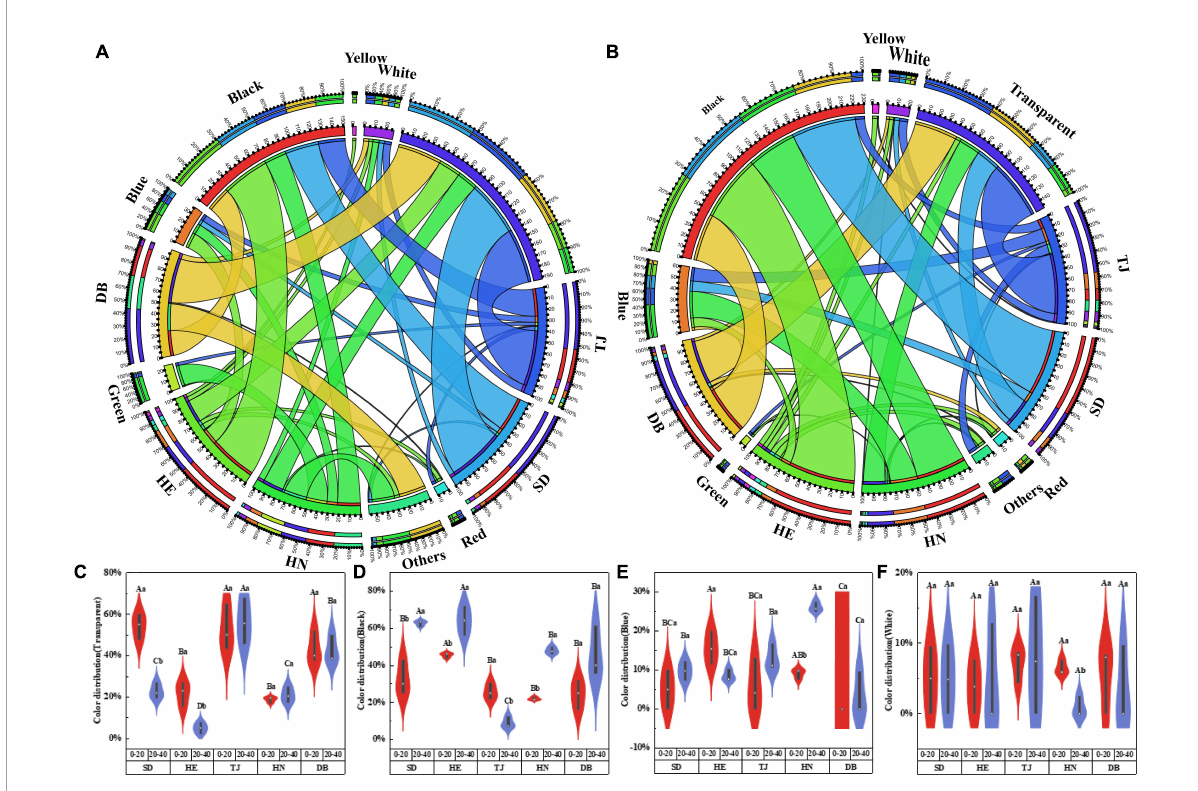
FIGURE4 Color (A) in 0–20 cm, color (B) in 20–40 cm distribution of MPs in different paddy soils; violin plots showing the variance analysis of four colors: transparent (C) ; black (D) ; blue (E) ; white (F) . Different capital letters indicate the significant difference among different geographic positions, and different lowercase letters indicate the significant differences between soil depths ( P < 0.05) ( n = 3).